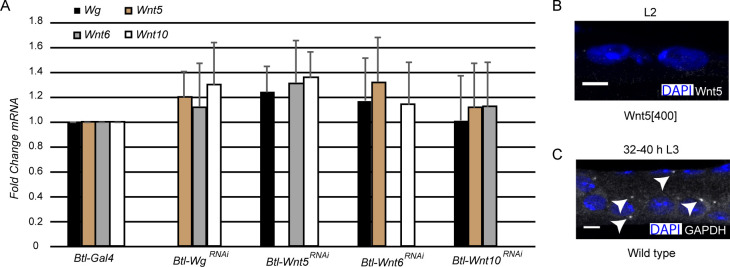
Wnt ligands do not affect each others expression.(A) Impact of knockdown of Wnt10 on cell numbers in Tr2 DT. Graph shows cells numbers in wild type (btl-GAL4, Same as Figure 1B) and Btl-Wnt10RNAi(btl-GAL4/UAS-Wnt10RNAi) at L2 and 16–24 h L3 (mean values ± standard deviation, n ≥ 7 tracheae). (B) smFISH for Wnt5 mRNA in Wnt5 mutant (Wnt5[400] FRT19A) Tr2 DT at L2. (Scale bar = 5 µm). (C) smFISH for GAPDH mRNA in Wild type (btl-GAL4) Tr2 DT at 32–40 h L3. Arrowheads point to the sites of mRNA accumulation. (Scale bar = 5 µm). (D) Quantitative PCR analysis of Wg, Wnt5, Wnt6 and Wnt10 mRNA levels in micro-dissected Tr2 DT fragments at L2. Graph shows fold change in Wg, Wnt5, Wnt6 and Wnt10 mRNA in Wild type (btl-GAL4), Btl-WgRNAi (btl-GAL4/+; UAS-WgRNAi/+), Btl-Wnt5RNAi(btl-GAL4/+; UAS-Wnt5RNAi/+), Btl-Wnt6RNAi(btl-GAL4/+; UAS-Wnt6RNAi/+) and Btl-Wnt10RNAi(btl-GAL4/+; UAS-Wnt10RNAi/+) in Tr2 DT fragments. Fold change has been represented with respect to Wild type (n = 3 experiments, n ≥ 15 Tr2 DT fragments/condition/experiment, mean ± standard deviation).